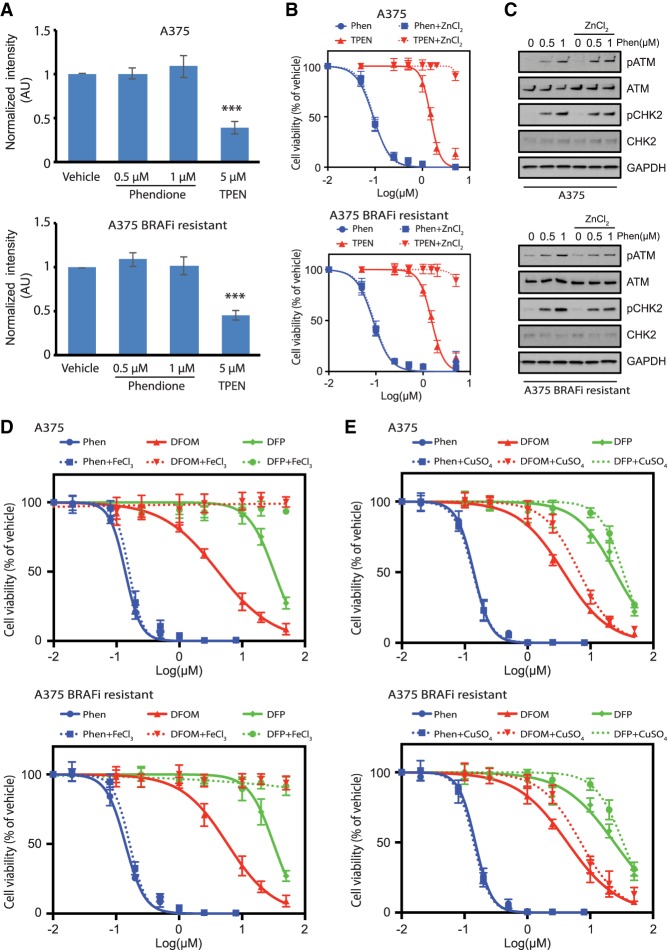
Phendione does not chelate intracellular cations. (A) Quantification of fluorescent intensity in the cells labeled with zinc indicator by flow cytometry. A375 (top) and A375 BRAFi-resistant (bottom) cells were treated with vehicle, phendione or cell-permeable zinc chelator TPEN for 3 h. At the end of treatment, 20 µM zinquin ethyl ester was added into medium to stain Zn2+ in live cells. Unstained cells were used as negative control for flow cytometry. (***) P < 0.001 by unpaired two-tailed Student's t-test. (B) Growth inhibition curves of A375 (top) and A375 BRAFi-resistant (bottom) cells treated with phendione or zinc chelator TPEN prepared in regular medium or medium containing 15 µM ZnCl2. (C) Immunoblot of whole-cell lysate collected after the treatment of vehicle or phendione prepared in regular medium or medium containing 15 µM ZnCl2 as indicated. (D,E) Growth inhibition curves of A375 (top) and A375 BRAFi-resistant (bottom) cells after 96 h of treatment with phendione or ion chelators DFOM or DFP prepared in regular medium or medium containing 50 µM FeCl3 (D) or 10 µM CuSO4 (E).